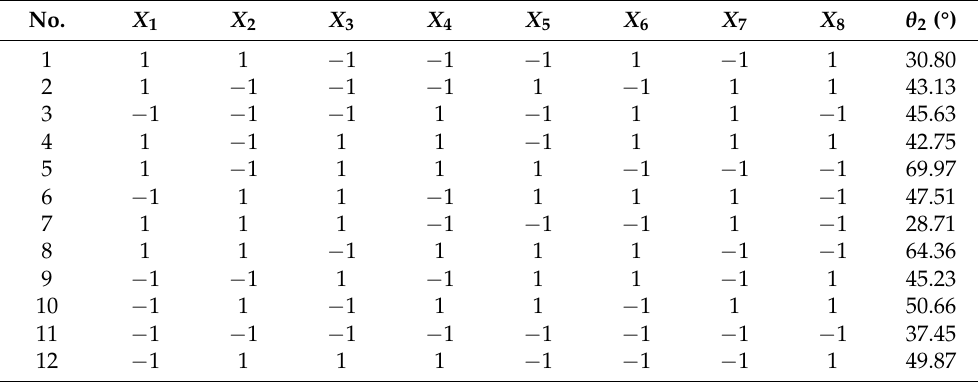
Table 5. Plackett–Burman test design and results.